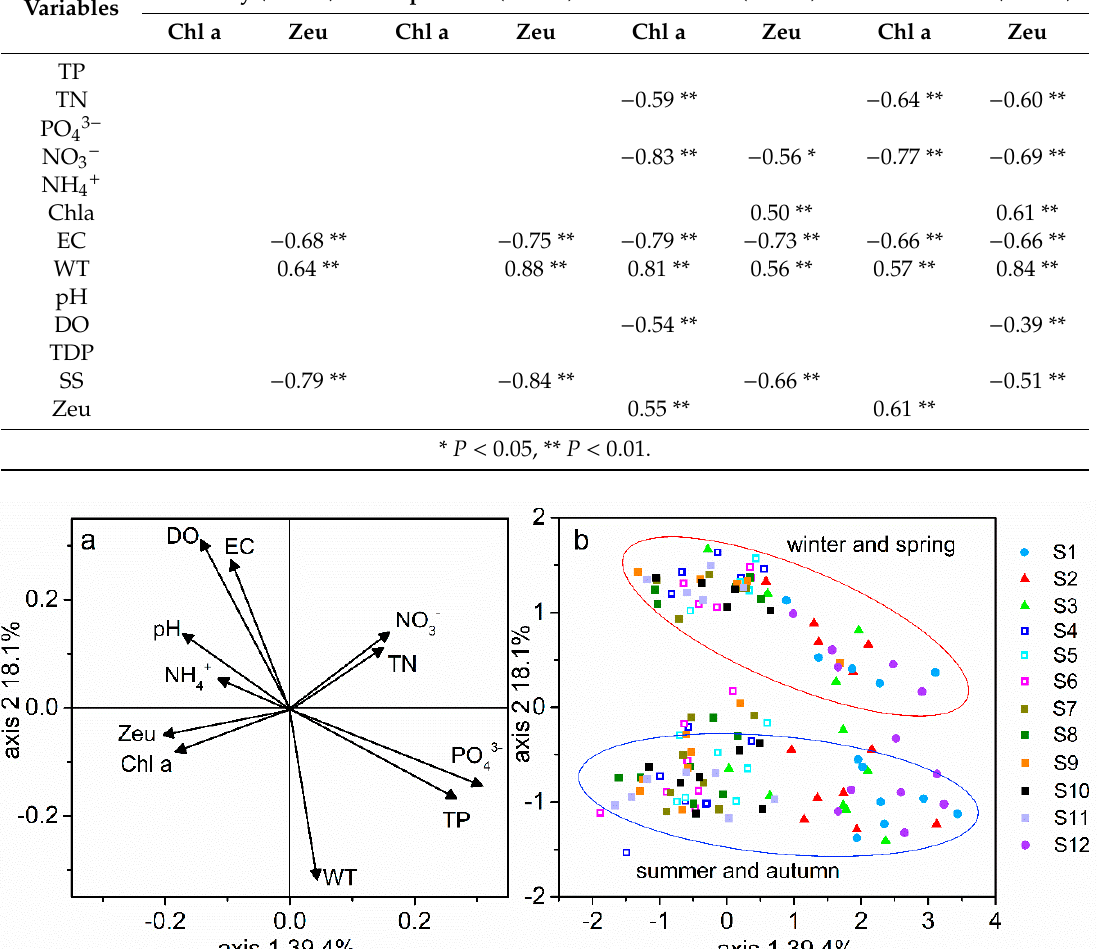
Figure 4. PCA variables loading plot ( a ) and samples (n = 144) score plot ( b ) for axis 1 and axis 2. ( b )